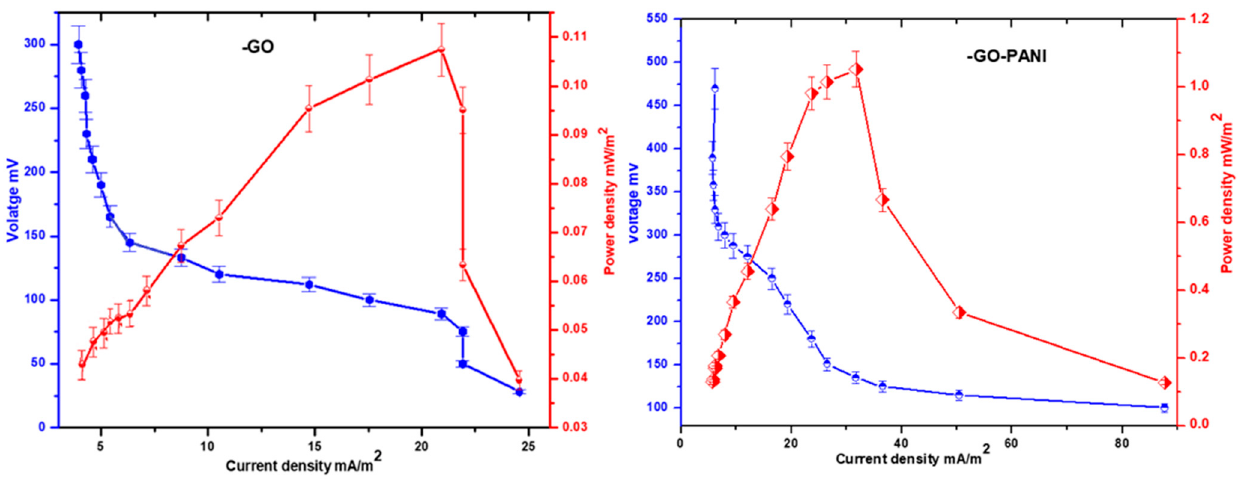
Figure 7. Polarization curves of the fabricated anodes.